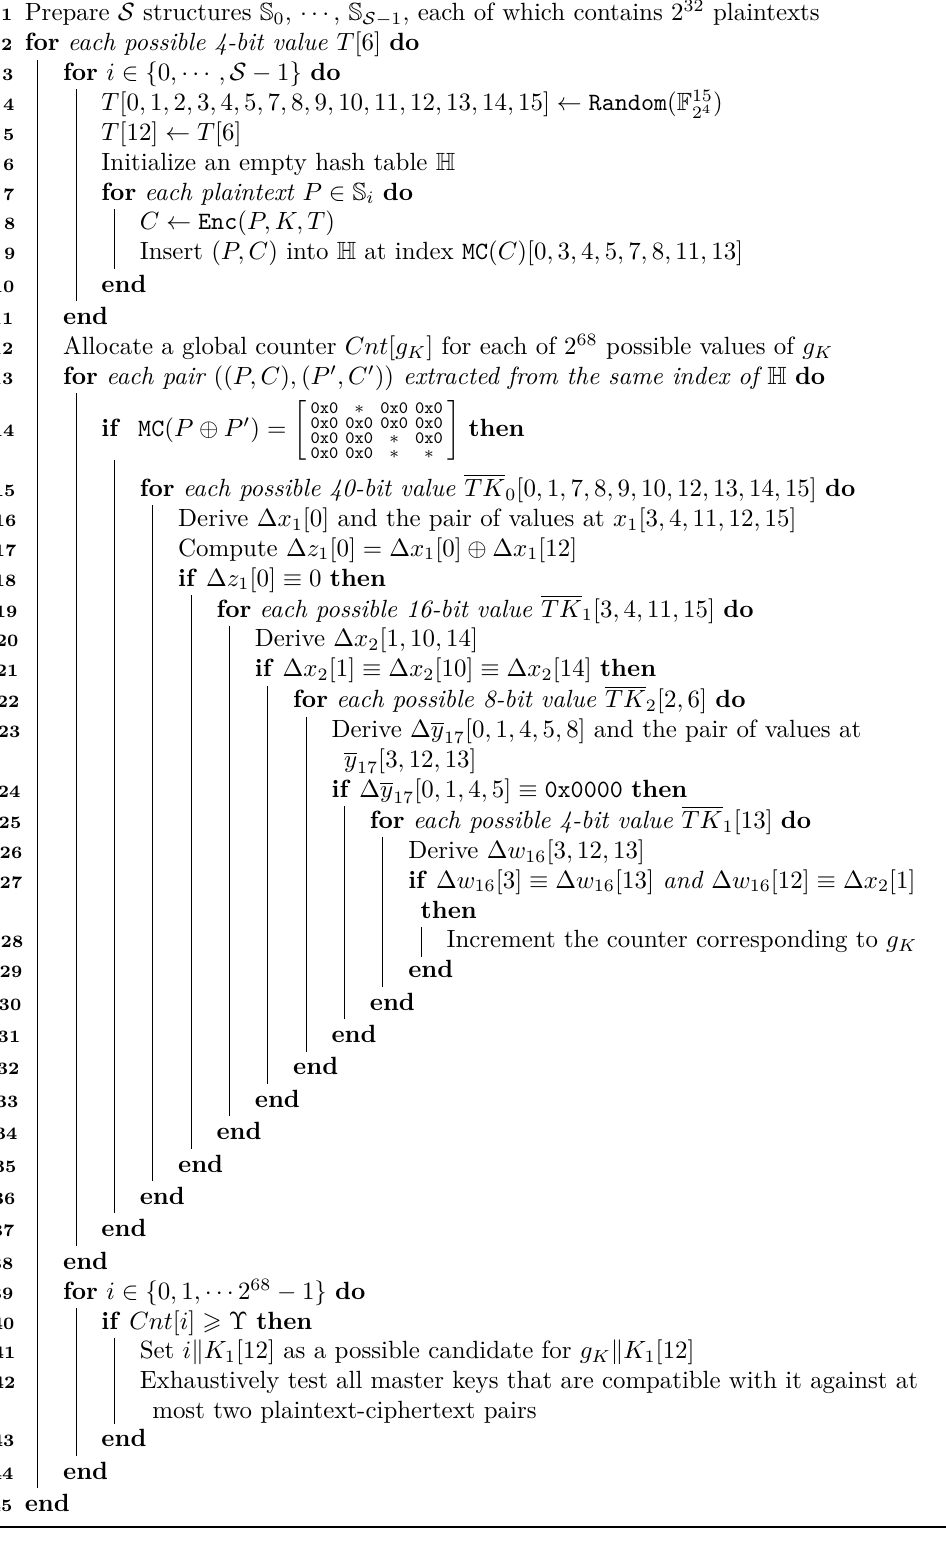
Algorithm 2: A 19-round key-recovery attack on